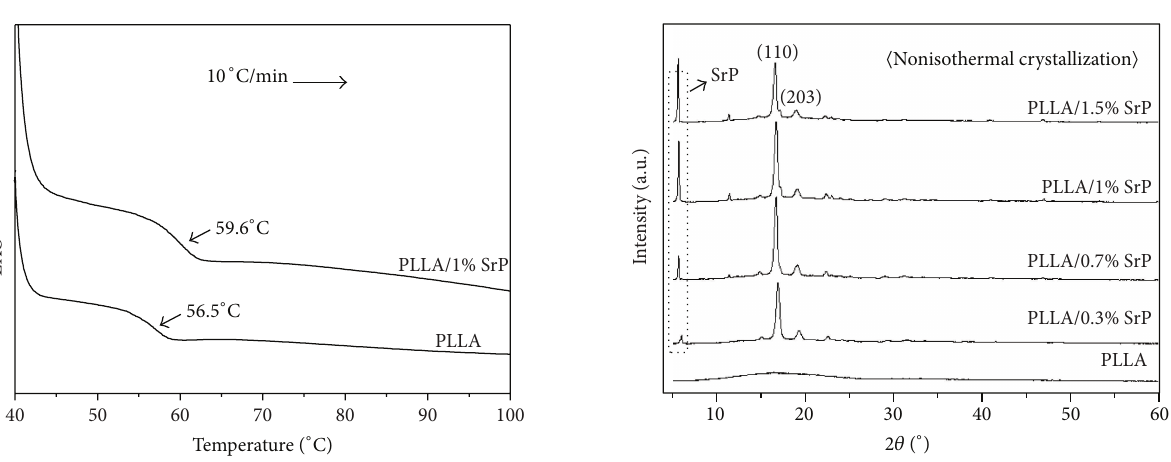
Figure 5: 𝑇 𝑔 of PLLA and PLLA/1% SrP after nonisothermal crystallization.